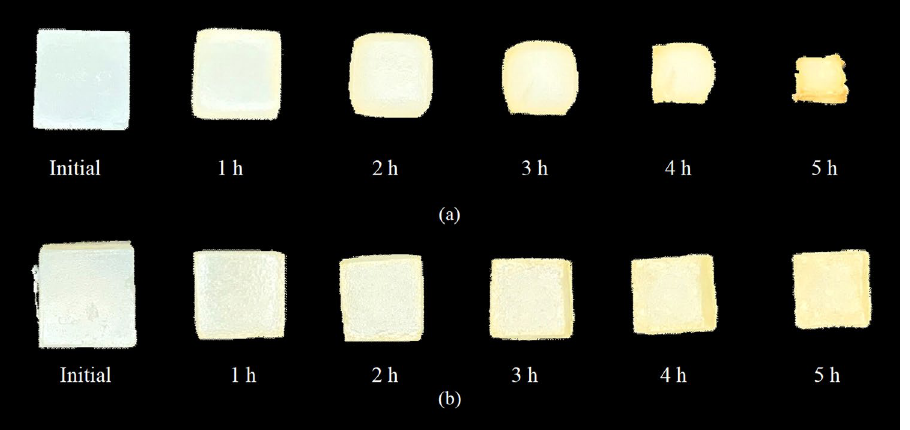
Figure 3. Deformation of agar cubes with ( a ) 0% sugar and ( b ) 20% sugar during drying at 80 °C.